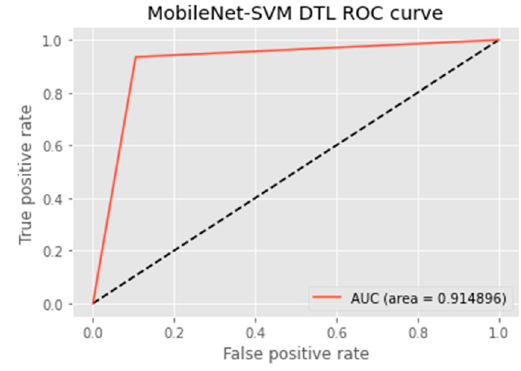
Figure 12. ROC curve of the MobileNet-SVM model .